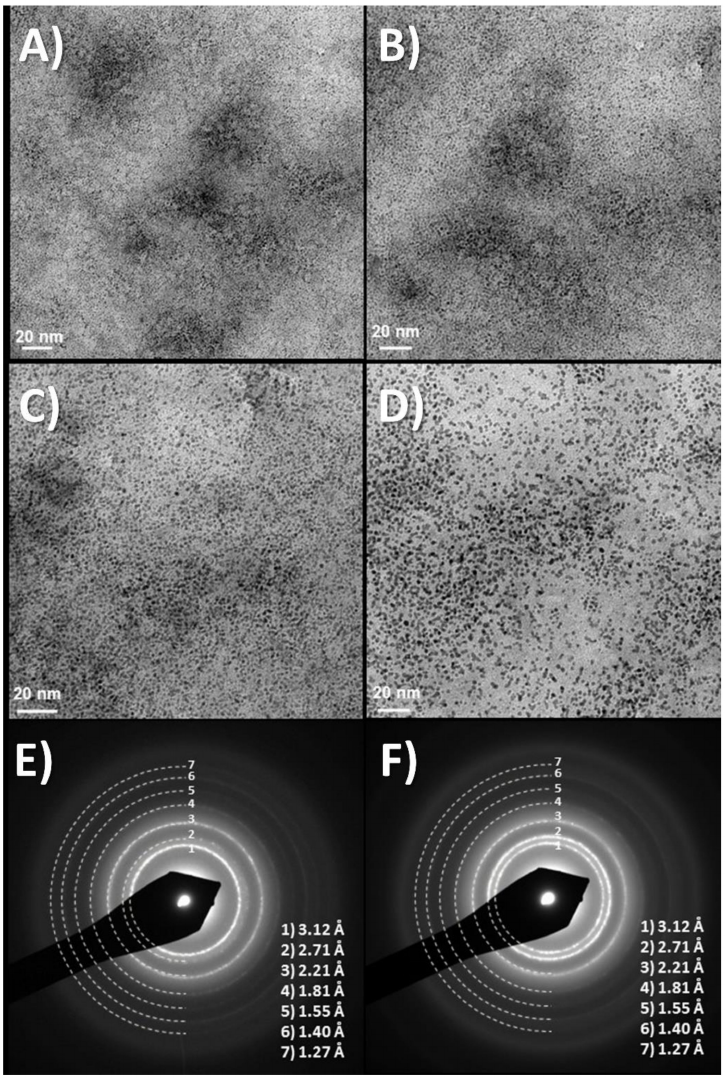
Figure 1. ( A – D ) Time evolution of TEM images at about 10 min intervals, showing TEM images of dry drops of Iridium oxo solutions obtained from hydrolysis of IrCl 3 , evolve under the electron